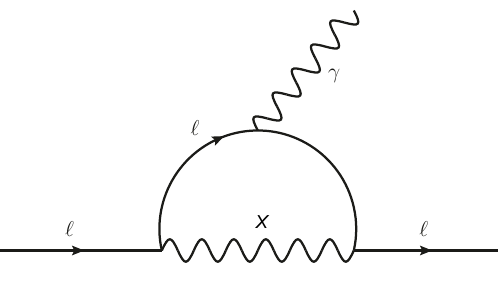
Figure 3 . Diagram contributing to the anomalous magnetic moment of charged leptons.